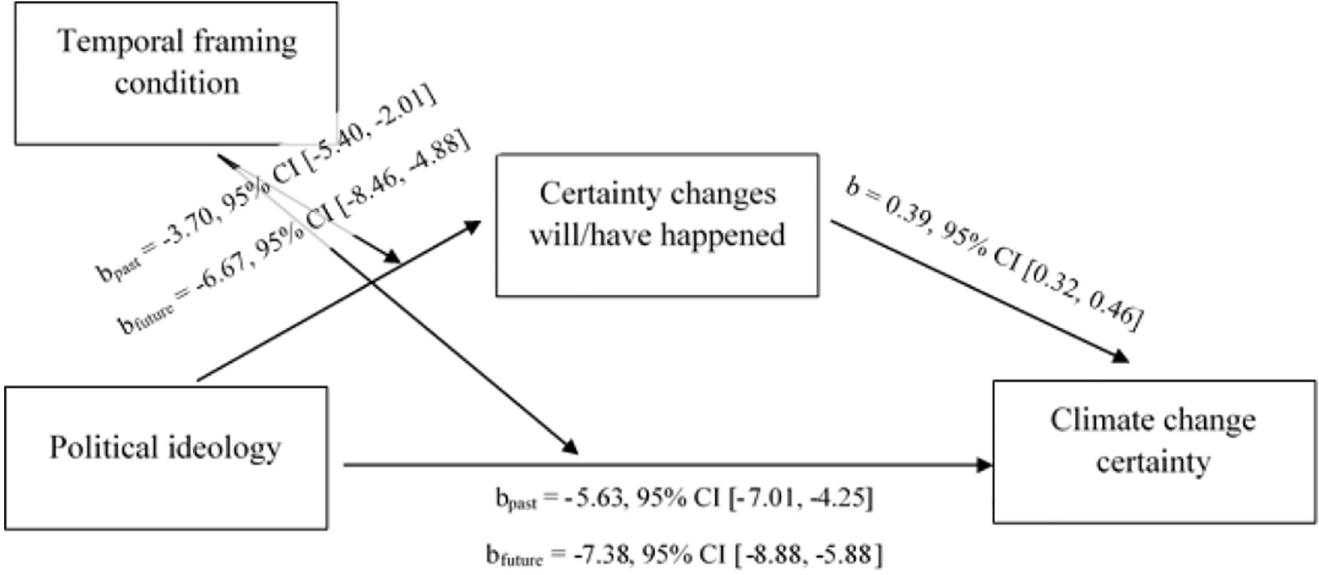
Fig 2. Effect of political ideology on climate change certainty is mediated by certainty that environmental changes have/will happen, dependent on temporal framing condition.